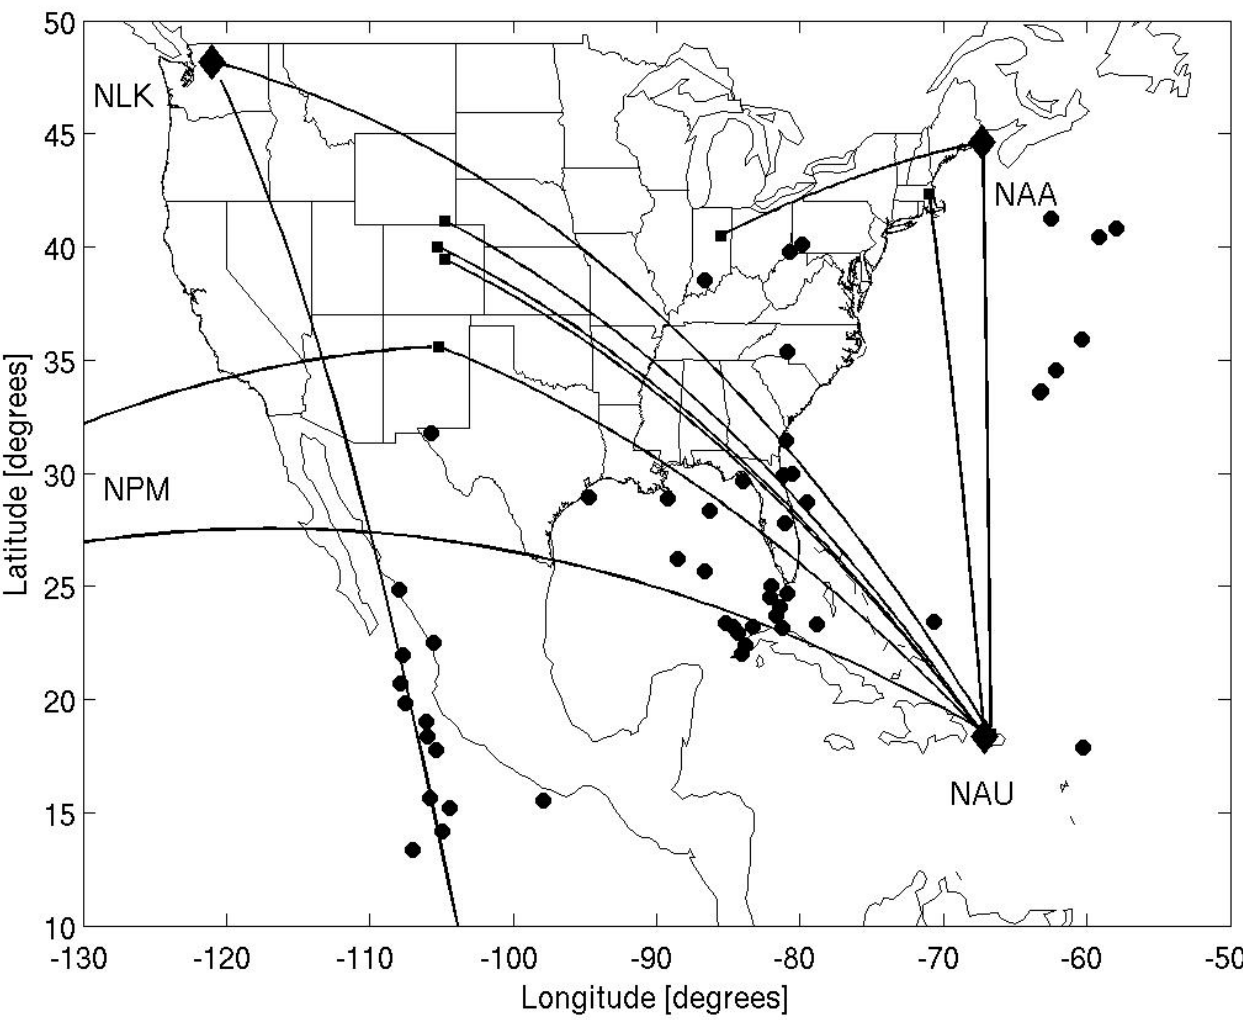
Fig. 6. Locations of the elves observed over the American continents during the period July 2004–July 2005 (circles). Solid lines represent the GCPs from the VLF transmitters (rhomboids) to the receiver sites (squares) considered in the present